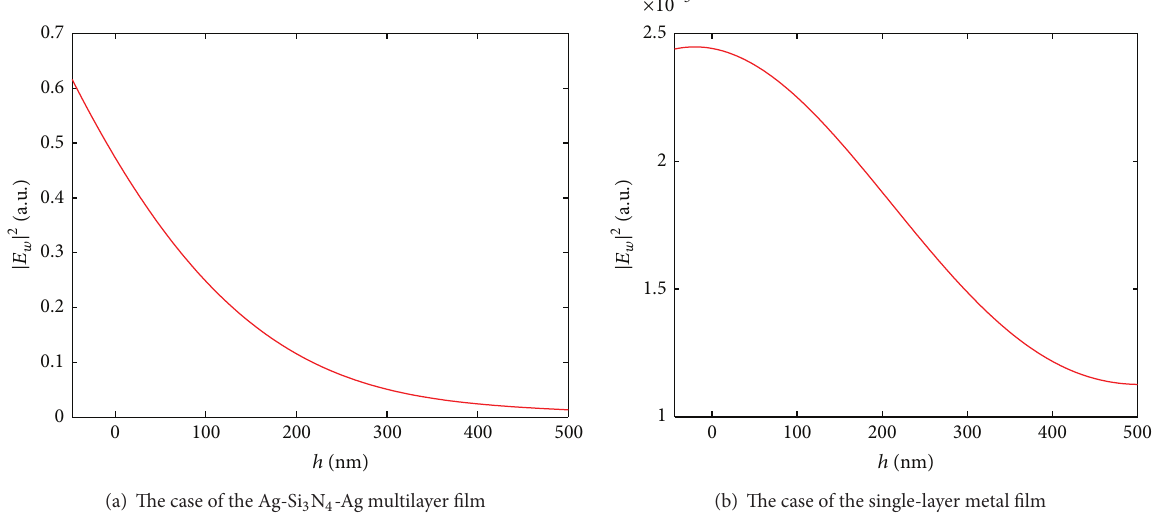
Figure 2: Intensity at the electric dipole versus the distance ℎ between the interface and geometric focus.